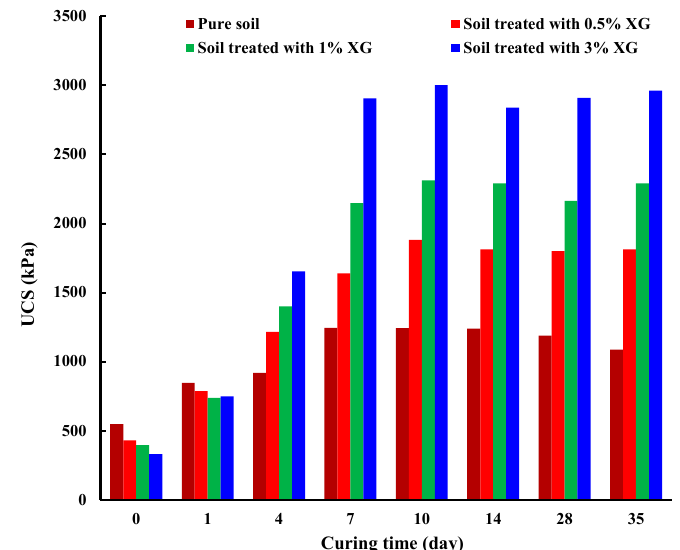
Figure 4. Changes in UCS with curing time.